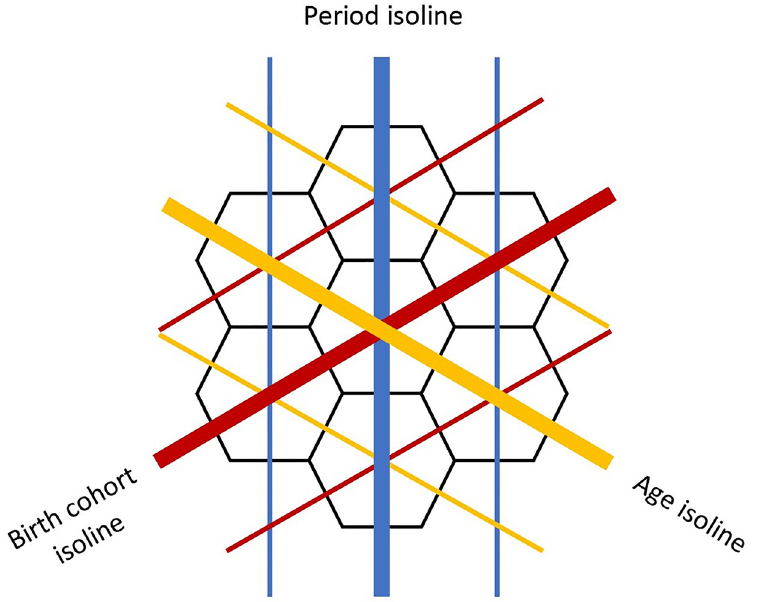
Fig 2. Hexamaps. Hexamaps visualize longitudinal population survey data by distinguishing by age, calendar year (period), and birth cohort along each of three axes. All points along an isoline share the same value one of the temporal